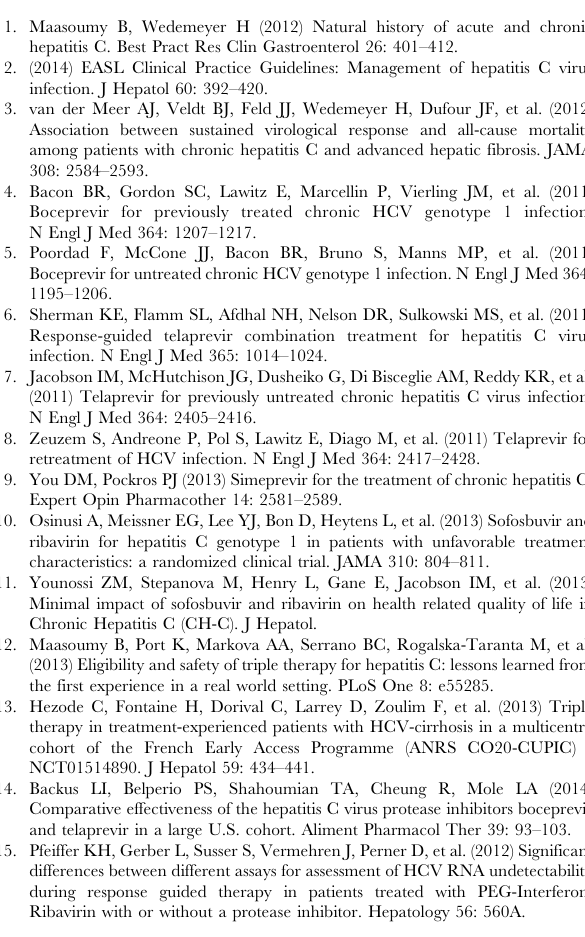
Table S1 All single HCV RNA test results and treatment outcome of the individual